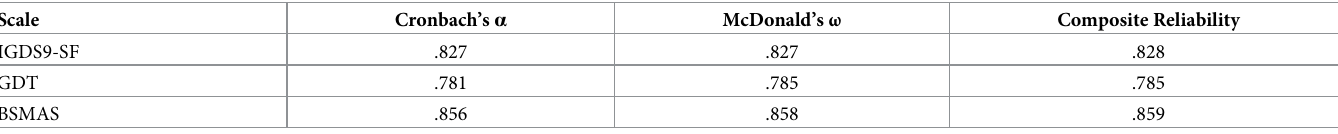
Table 3. Reliability analysis of the three scales ( N =